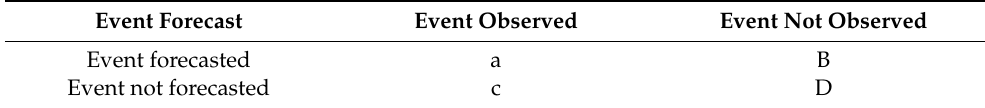
Table 1. Elements of the measure, forecast, and